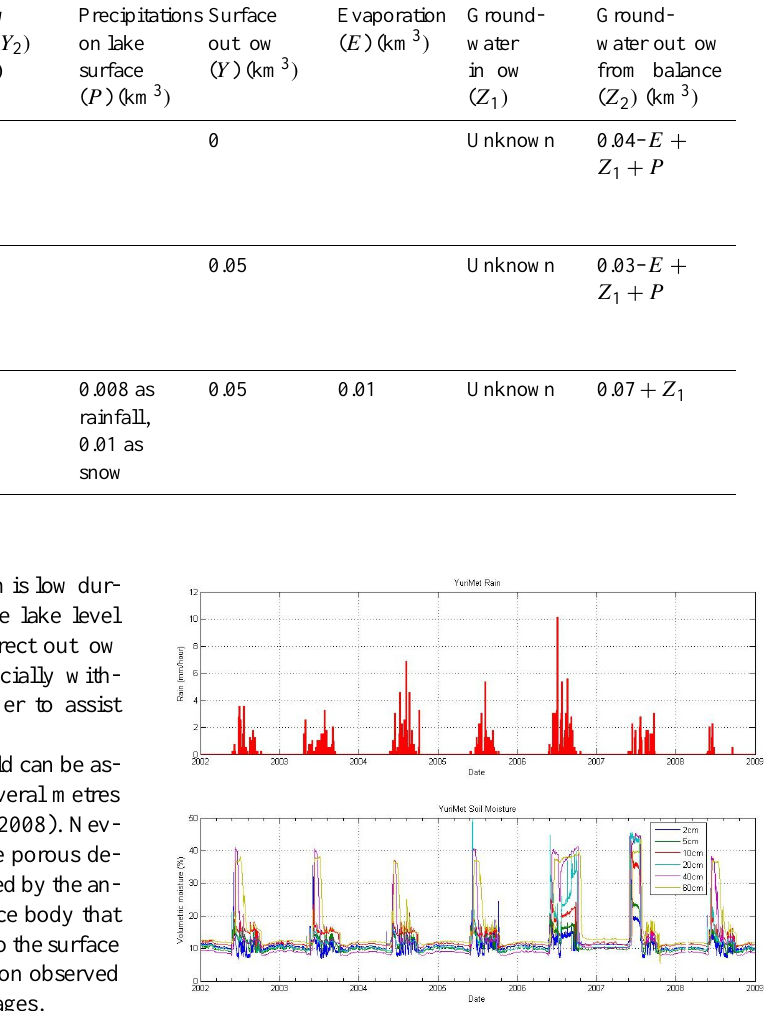
Fig. 5. Seven years of rain and soil moisture data from the out- wash plain of Lake El’gygytgyn. Rain fall, as measured by a tip- ping bucket, occurs mainly during the summer months of June, July and August, varying from 70, 73, 173, 106, 200 and 134mm from 2002 to 2007. The gauge apparently malfunctioned in June 2008. Soil moisture follow similar trends each year, except in 2006, when high rainfall left soils saturated at the end of summer. The moisture then froze and drained off the following summer. We believe these dynamics strongly support our conclusions that significant amounts of lake water can be stored in and migrate through these gravels, as described in the